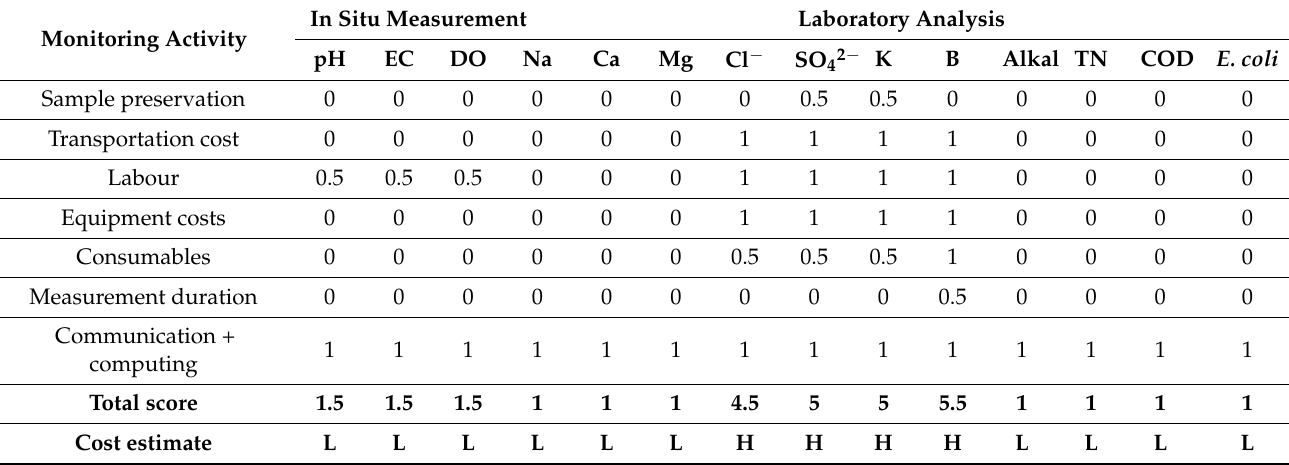
Table 8. An updated cost estimate per